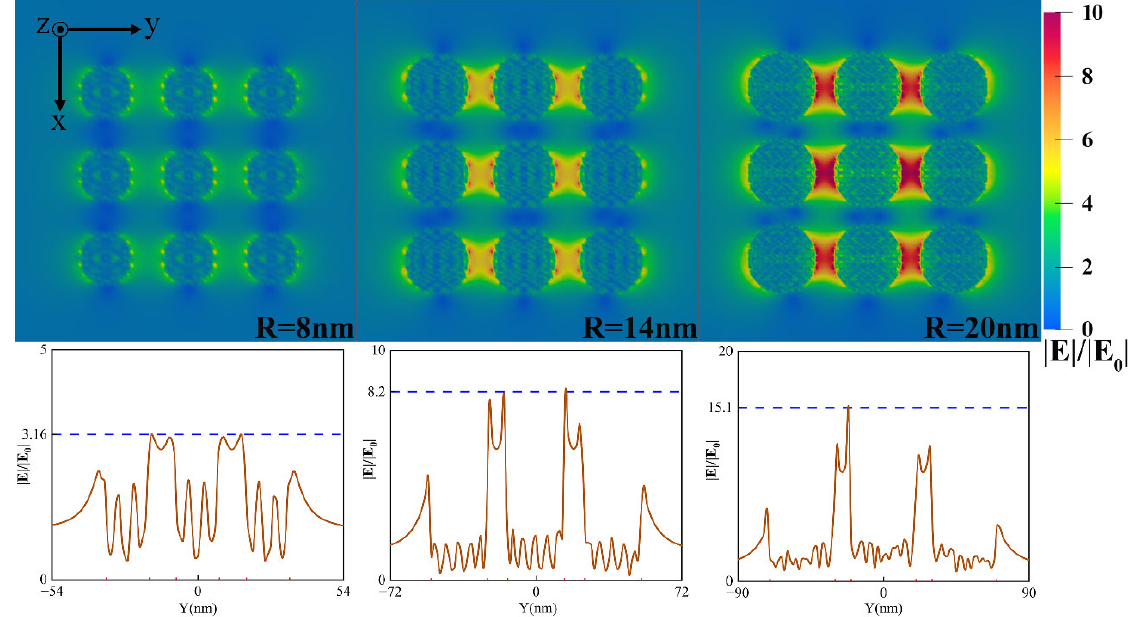
Figure 6. Near ‐ field enhancement of the  3 3 square array of Ag nanoparticles with the particle Figure 6. Near-field enhancement of the 3 × 3 square array of Ag nanoparticles with the particle spacing of 10nm and the incident light wavelength of 532 nm: near ‐ field distribution with different spacing of 10nm and the incident light wavelength of 532 nm: near-field distribution with different radius (the top) and field enhancement factor curve along the y ‐ axis of the array center (the bottom). radius (the top) and field enhancement factor curve along the y-axis of the array center (the bottom).